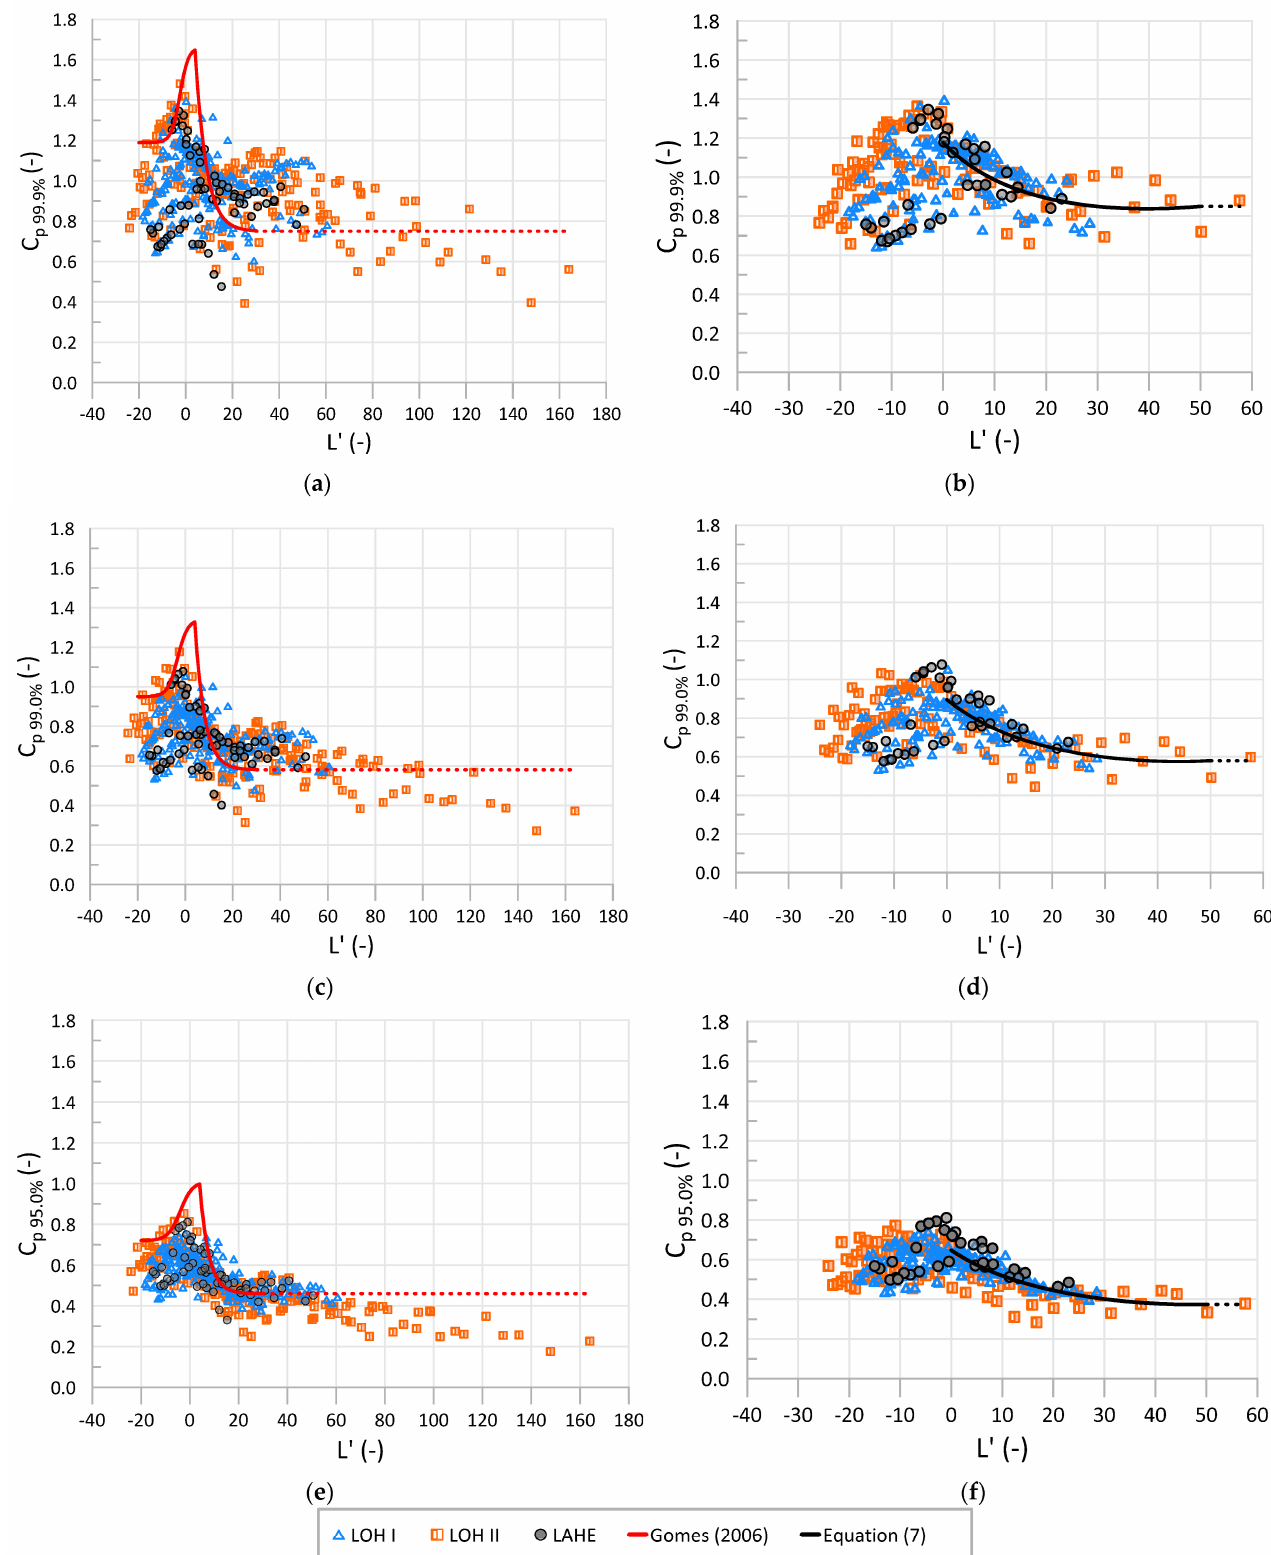
Figure 11. Streamwise development of the 99.9%, 99.0%, and 95.0% extreme pressure coefficients on the horizontal face of the step, near the outer edge, at the LOH I (blue color), LOH II (brown color), and LAHE (grey color) stepped chutes, for: ( a , c , e ) complete data set; ( b , d , f ) data relative to Re ≥ 2 × 10 5 and d c /h ≥